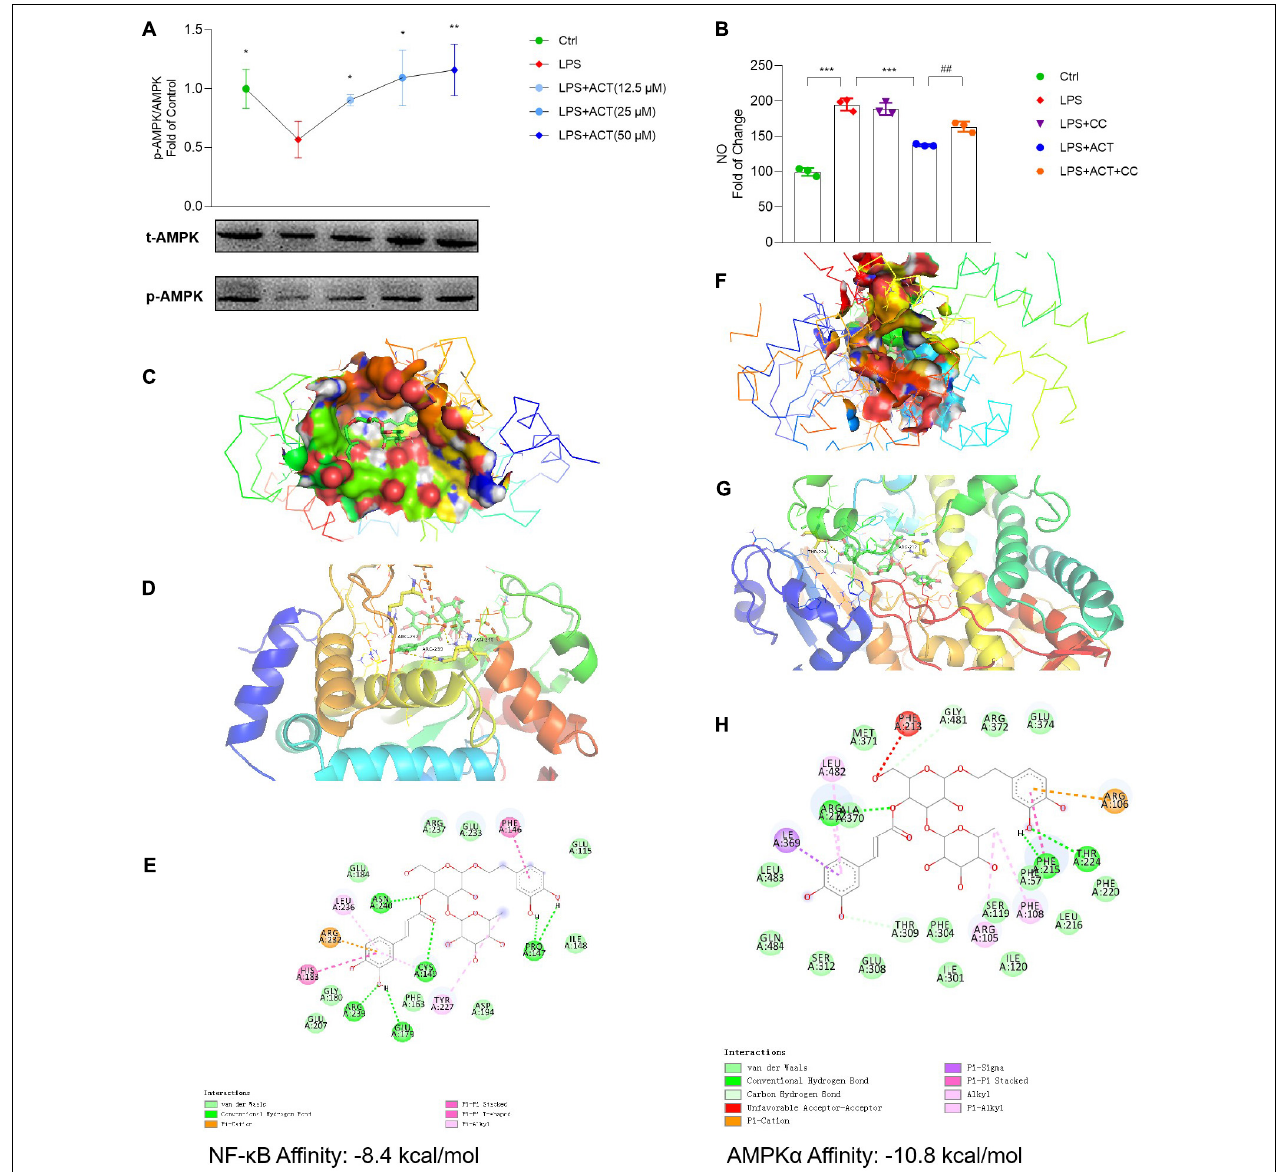
FIGURE 5 | ACT bond to and inhibited NF- κ B as well as activated AMPK α . (A) ACT distinctly increases the phosphorylation level of AMPK α . (B) The effect of compound C (1 µ M) on NO level. *** P < 0.001, versus the LPS group. ## P < 0.01, versus the LPS+ACT group. n = 3. (C) A three-dimensional visual of the binding sites between ACT and NF- κ B. (D) A two-dimensional close-up of the molecule binding pocket from the side. (E) Amino acid residues. (F) A three-dimensional visual of the binding sites between ACT and AMPK α . (G) A two-dimensional close-up of the molecule binding pocket from the side. (H) Amino acid